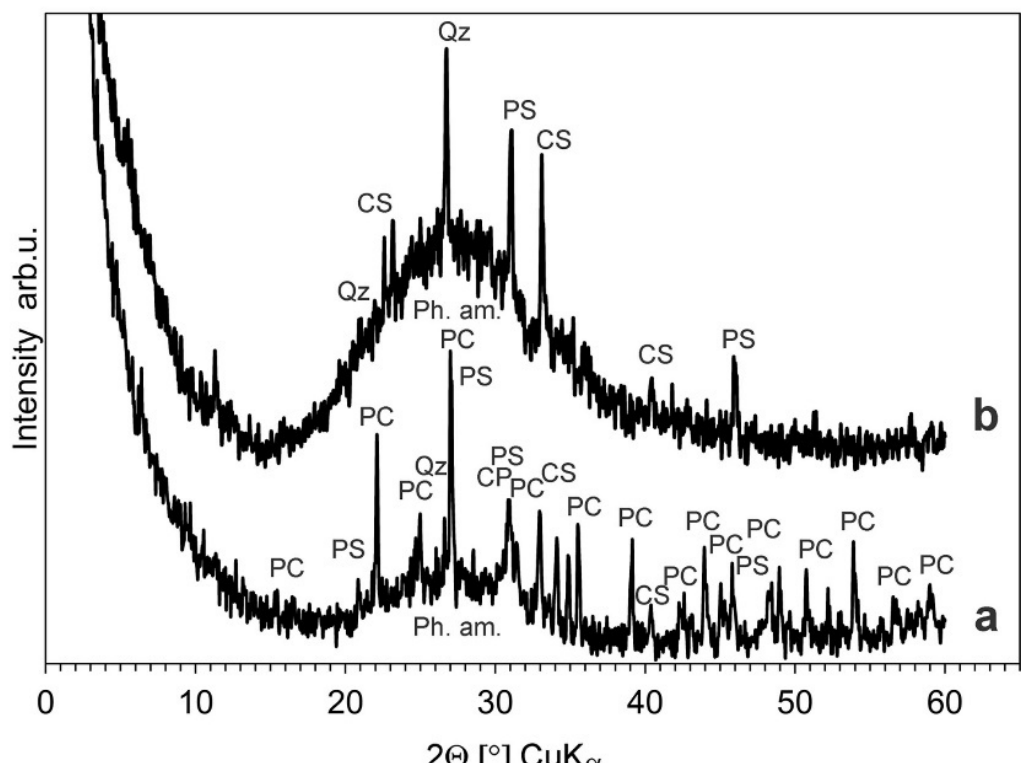
Figure 9. Characteristic X-ray diffractogram of the blue bead: ( a ) surface with a white substance filling the bead ornamentation, ( b ) the underside surface of the bead. Abbreviations: PC—Pb(OH)Cl (52-289), PS–Pb 36 ((Si 2 O 7 ) 6 (Si 4 O 13 ) 3 O 3 ) (44-271), Pb 33 (Si 2 O 7 ) 6 (Si 4 O 13 ) 3 (44-273), Pb 5 Si 3 O 11 (31-692), PCS—Pb 8 Ca(Si 2 O 7 ) 3 (32-514), CS—Ca 2 SiO 4 (23-1042), Qz—quartz SiO 2 (33-1161), CP—Ca 3 (PO 4 ) 2 (9-348), Ph. am.–amorphous phase.